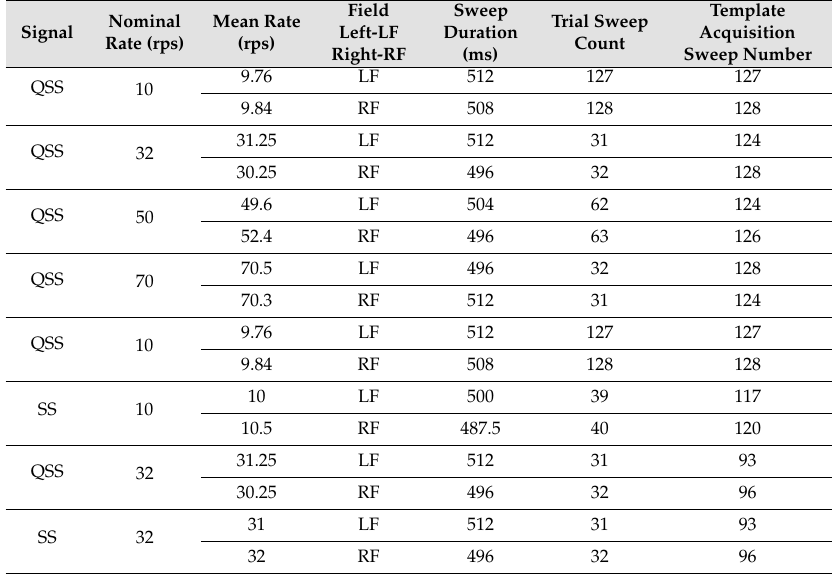
Figure 1. Overall system setup and the experimental procedure are shown for a 10 rps stimulation. The stimulator is shown at the top left, driving sequences for the left field (LF) and right field (RF) are shown at the bottom left, the quasi-steady-state (QSS) and transient responses from subject 5 are shown in the bottom right figures. Interference signals after averaging 127/128 sweeps in one file for left / right, y RL ( t ) and y LR ( t ) , are also displayed to highlight the orthogonality of the sequences. Refer to Section 2.4 and abbreviation list at the end of the paper for the abbreviations used in the figure. Table 1. Stimulation properties for quasi-steady-state (QSS) and steady-state (SS) stimulation paradigms and sweep number used for template